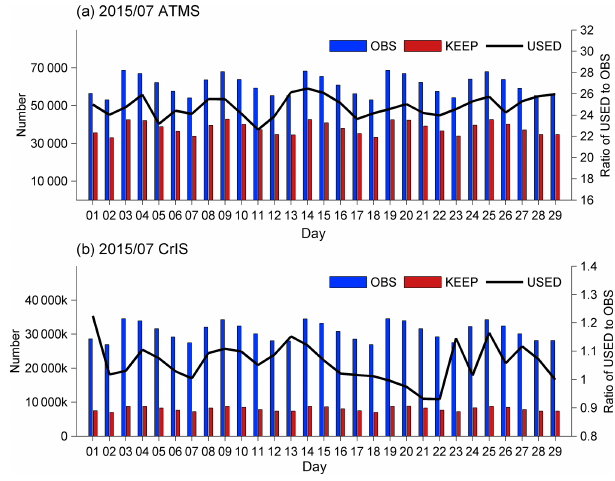
Figure 2. Blue bars indicate the total amount of radiance read in the DA system. Red bars present the number of kept radiance after first step of quality control. The percentage used after final quality control is shown as black curves. The right y axis indicates the ratio of used amount to read amount, and the ratio is expressed as percent. (a) is for ATMS, and (b) is for CrIS data